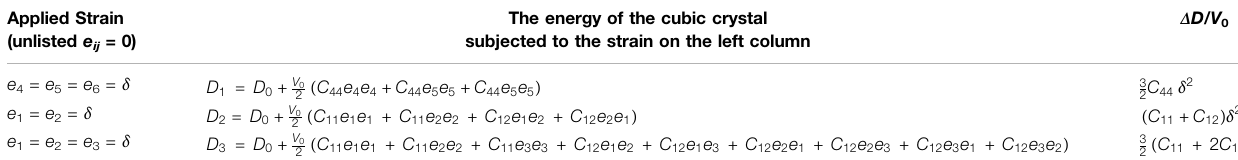
TABLE 1 | Strains used to calculate the elastic constants of β -Ti X ( X = Nb, Ta) alloys. Applied Strain (unlisted e ij = 0)